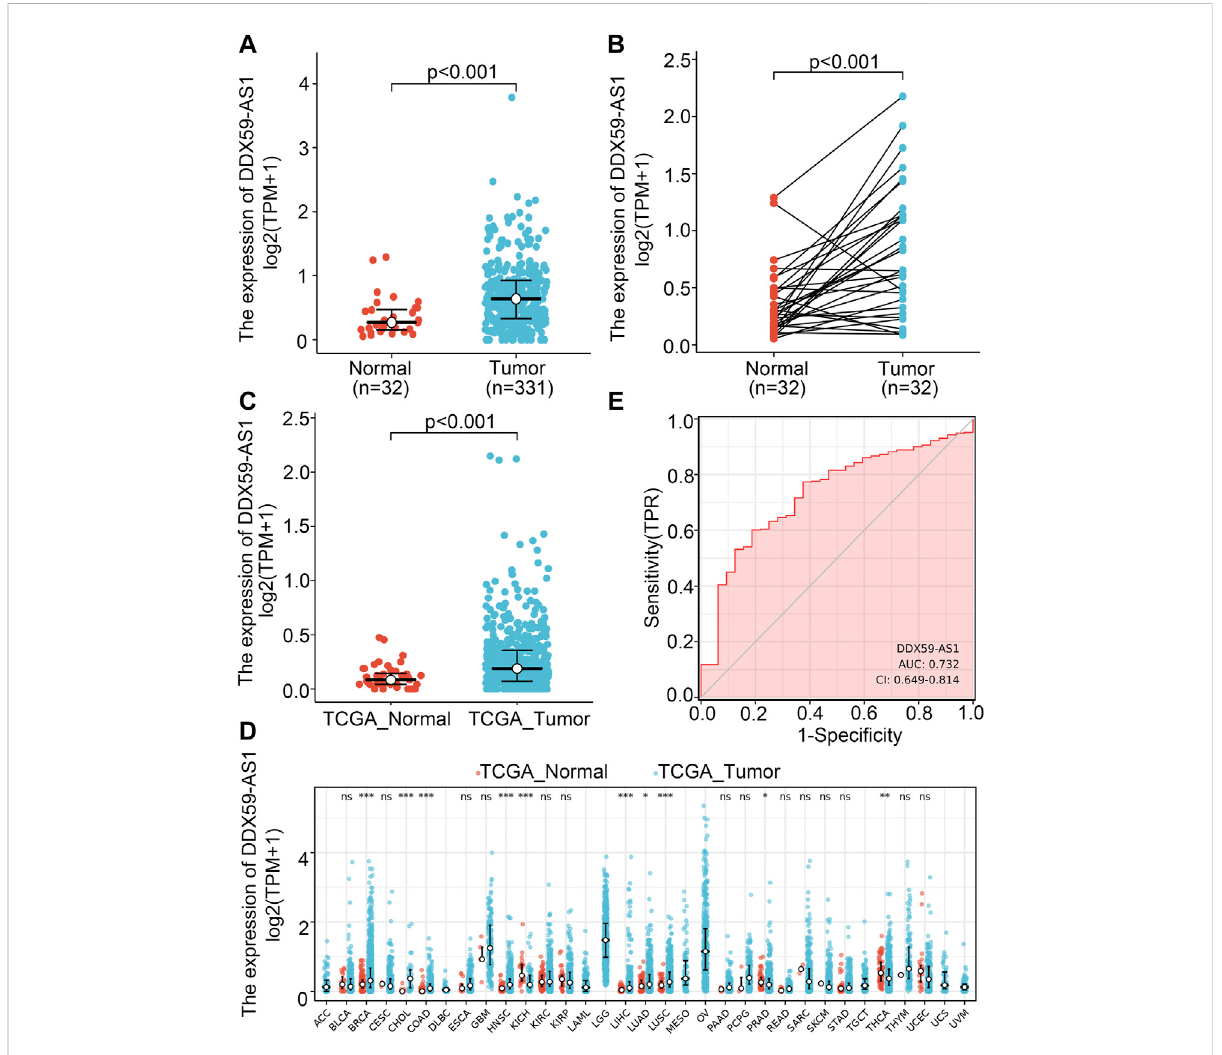
FIGURE 2 DDX59-AS1expressionbetweencancerandnormaltissuesinOSCCpatients. (A) DDX59-AS1expressionlevels inOSCCandnormaltissues; (B) DDX59-AS1 expression levels in OSCC and matched normal tissues; (C) DDX59-AS1 expression between cancer and normal tissues in HNSCC; (D) The comparison of DDX59-AS1 expression between cancer and normal tissue in different types of cancers based on TCGA database; (E) ROC analysis ofDDX59-AS1shows promising discrimination powerbetweencancerand normal tissues. ns, p ≥ 0.05;*, p < 0.05;**, p < 0.01; ***, p <